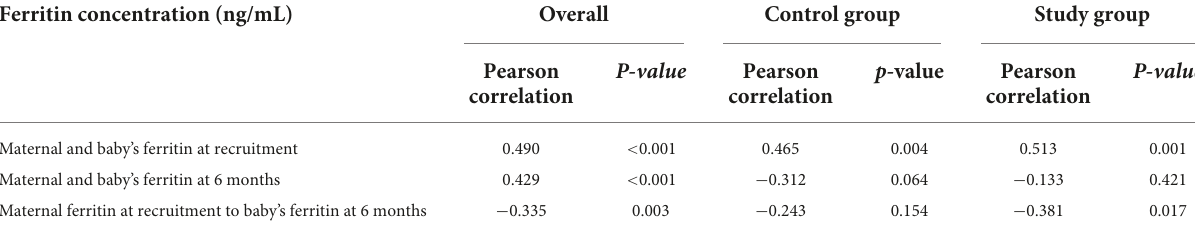
TABLE 7 Correlation of maternal serum ferritin concentration with those of infants at recruitment and 6 months. Ferritin concentration